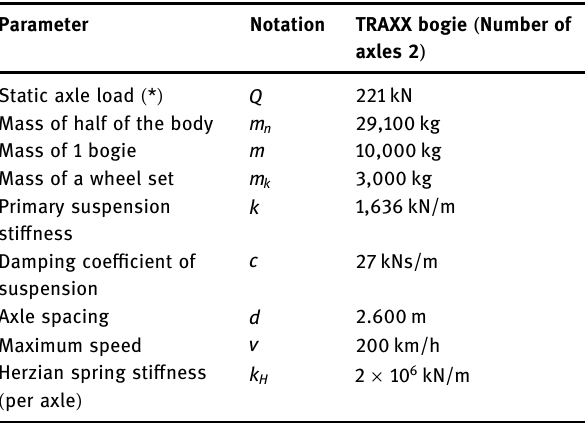
Table 3: Traxx locomotive parameters assumed for model valida